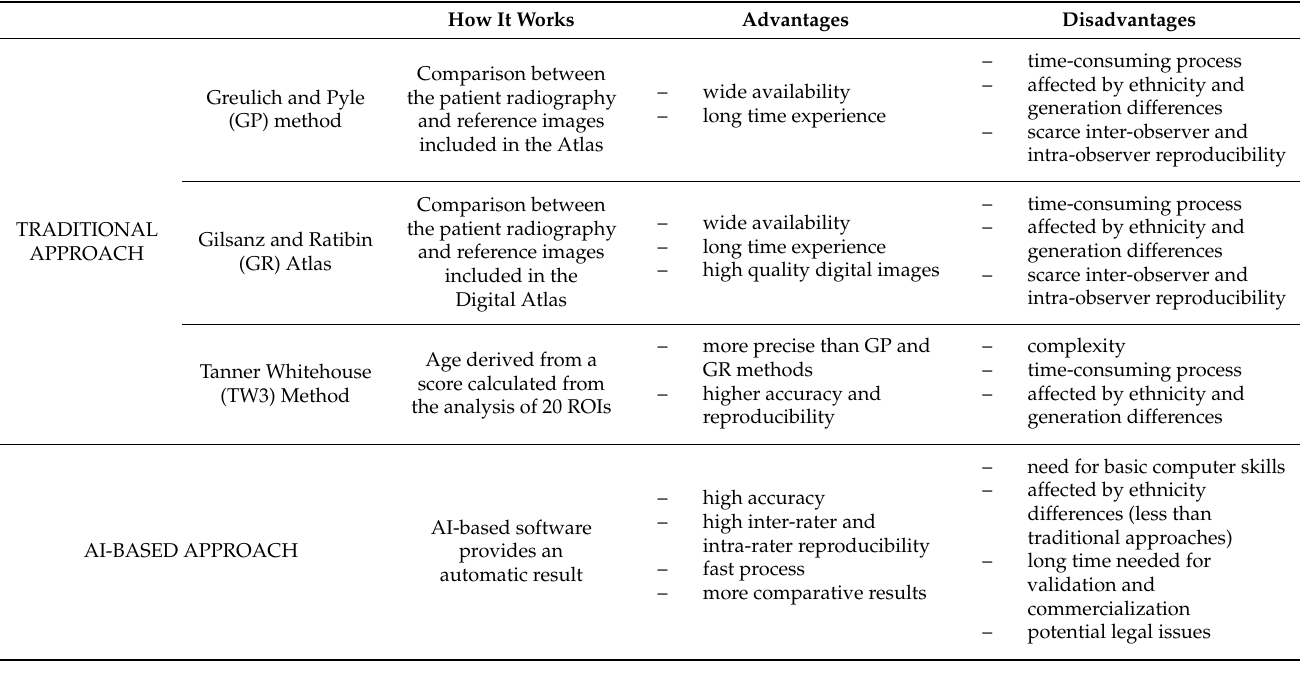
Table 3. Advantages and disadvantages of traditional and AI-based approaches for bone age estima- tion from hand